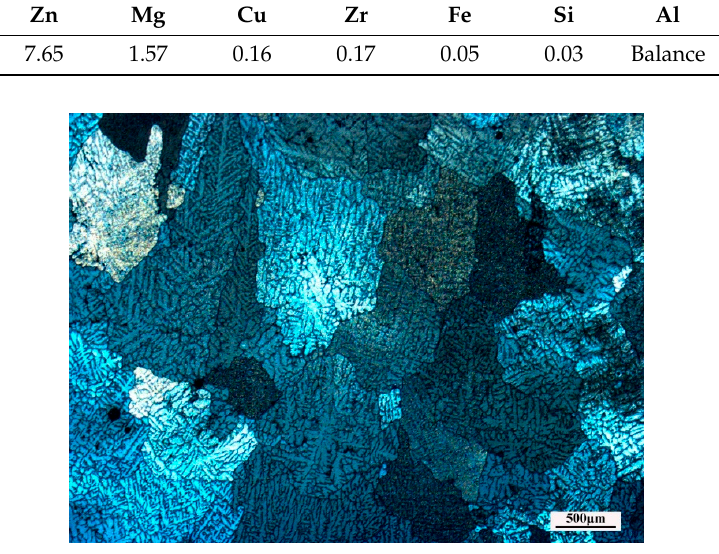
Figure 9. Optical microstructure of the as-homogenized Al–7.5Zn–1.5Mg–0.2Cu–0.2Zr alloy.